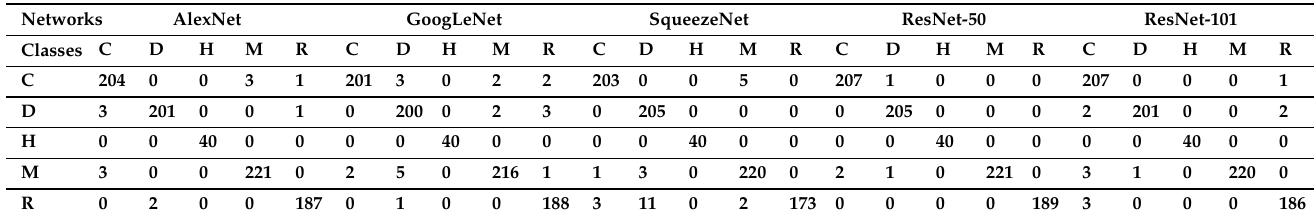
Table 8. Confusion matrix obtained using several state-of-the-art